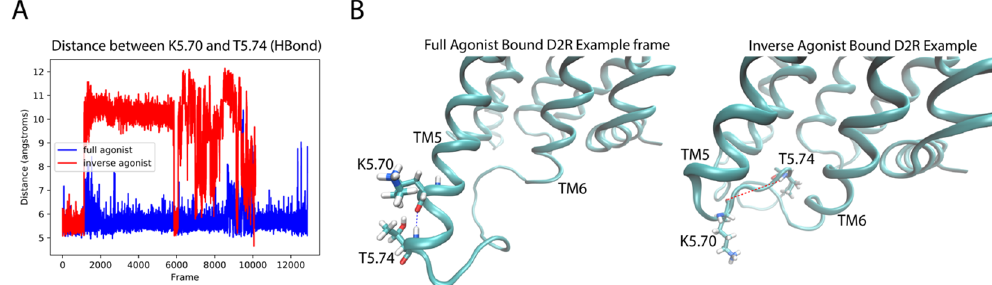
Figure 12. Residues K5.70 and T7.54 identified by the D2R sensitivity analysis determine the helicity of the intracellular TM5 extension. ( A ) The distance between the backbone oxygen of K5.70 and the backbone amide hydrogen of T5.74 along trajectories of D2R bound to the full agonist (in blue) and the inverse agonist (red). ( B ) Illustrative frames from the trajectories in panel A chosen for the distinct difference in the distance, and its effect on the helicity of the intracellular end of TM5.